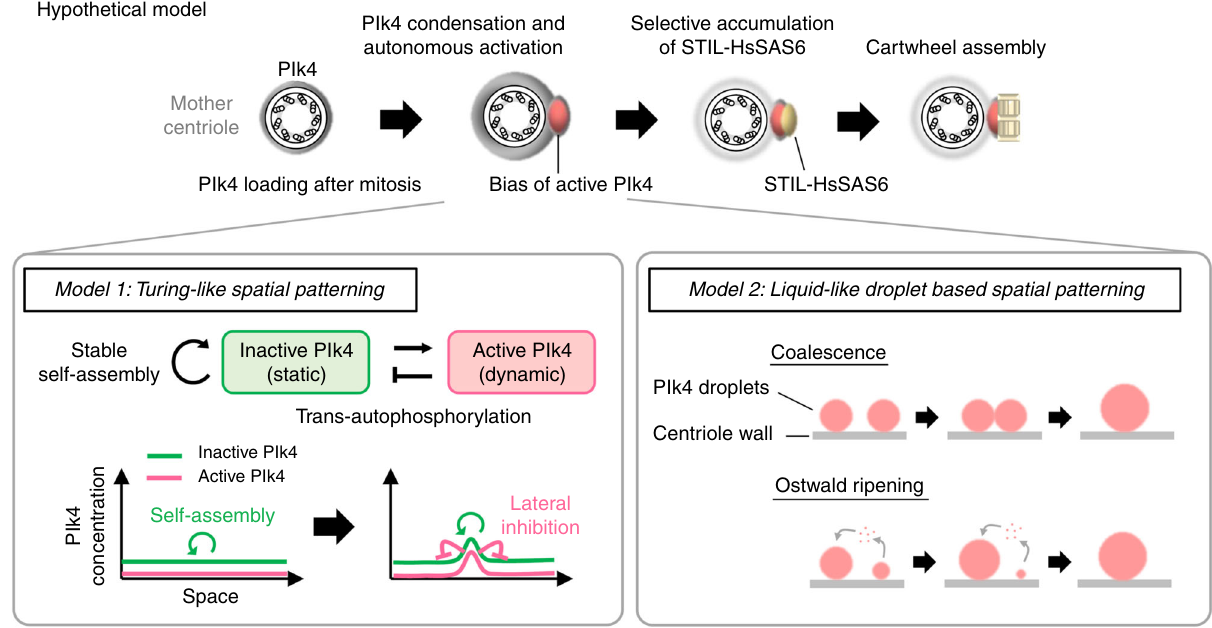
Fig. 6 Hypothetical model: self-organization of Plk4 directs a single daughter centriole formation per mother centriole. Schematic illustration of hypothetical model. Increasing centriolar Plk4 concentration after mitosis drives condensation and autonomous activation of Plk4 prior to STIL-HsSAS6 loading. Self-organization property of Plk4 driven by the regulated condensation induces spatial pattern formation of autophosphorylated Plk4, which results in a bias formation of activated Plk4. The single focus is a possible target site for STIL-HsSAS6 loading. Model 1 : active and inactive Plk4 species that have different diffusion coef fi cients interact with and generate biased distribution of Plk4 around the mother centriole through trans-autophosphorylation. Inactive Plk4 stably self-assembles onto centrioles, while high concentration of Plk4 promotes autonomous activation of Plk4 through trans- autophosphorylation 14 . Activated Plk4 trans-autophosphorylates inactive Plk4 to become active state 14 and suppresses stable self-assembly of inactive Plk4. The interaction mode of these two components is similar to Turing ’ s reaction-diffusion model or its analog, the lateral inhibition model. Model 2 : active Plk4 proteins are phase-separated into liquid-like droplets around mother centrioles and they eventually form a single and large droplet of active Plk4 through coalescence or Ostwald ripening. Surface tension of Plk4 droplet may work as a key force shaping asymmetric structure of Plk4 around mother centrioles. These two models may cooperatively work for spatial pattern formation of